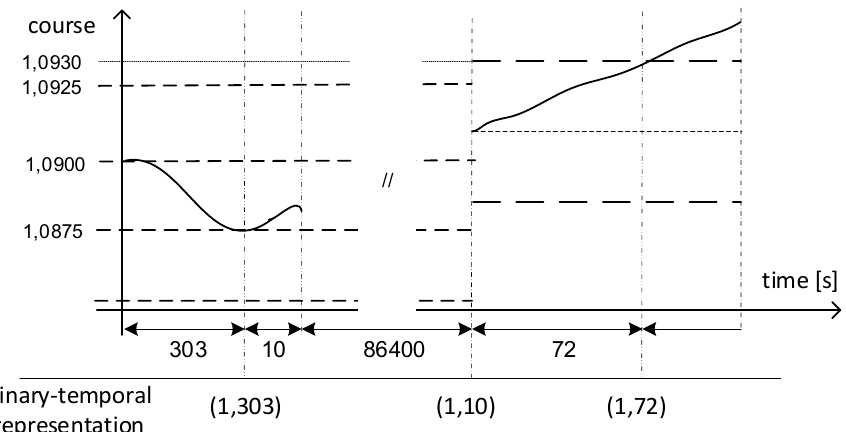
Figure 7. Binary-temporal representation algorithm’s performance during the session opening/closure.